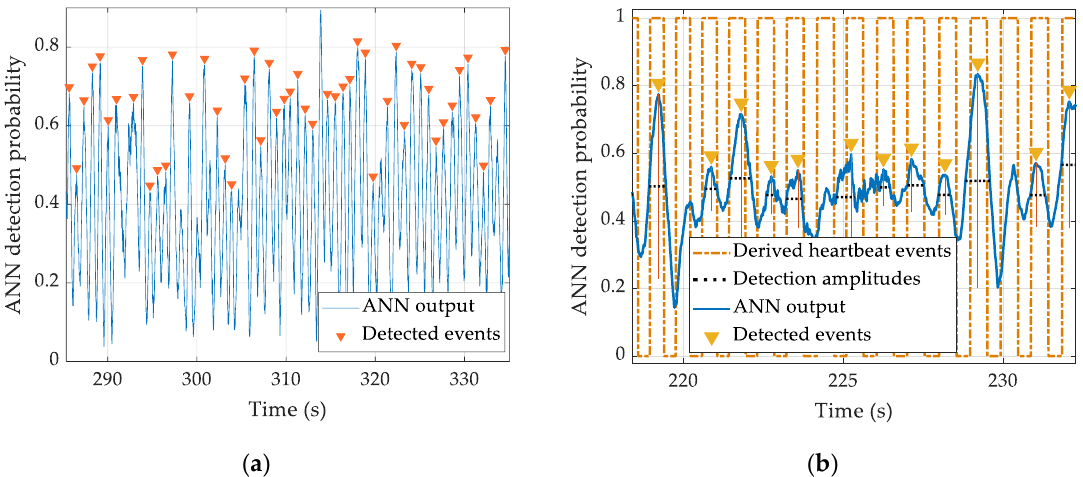
Figure 7. An example of the heartbeat’s method detection. Panel (a) shows the output of the FF 20 1 ANN smoothed with a moving average window, with the detected prominent peaks in a 50 s interval. Panel (b) shows the output of the FF 20 1 ANN smoothed with a moving average window on a shorter time scale plotted against the reference ECG (derived heartbeat events) for an easier visualization of the detected heart events.